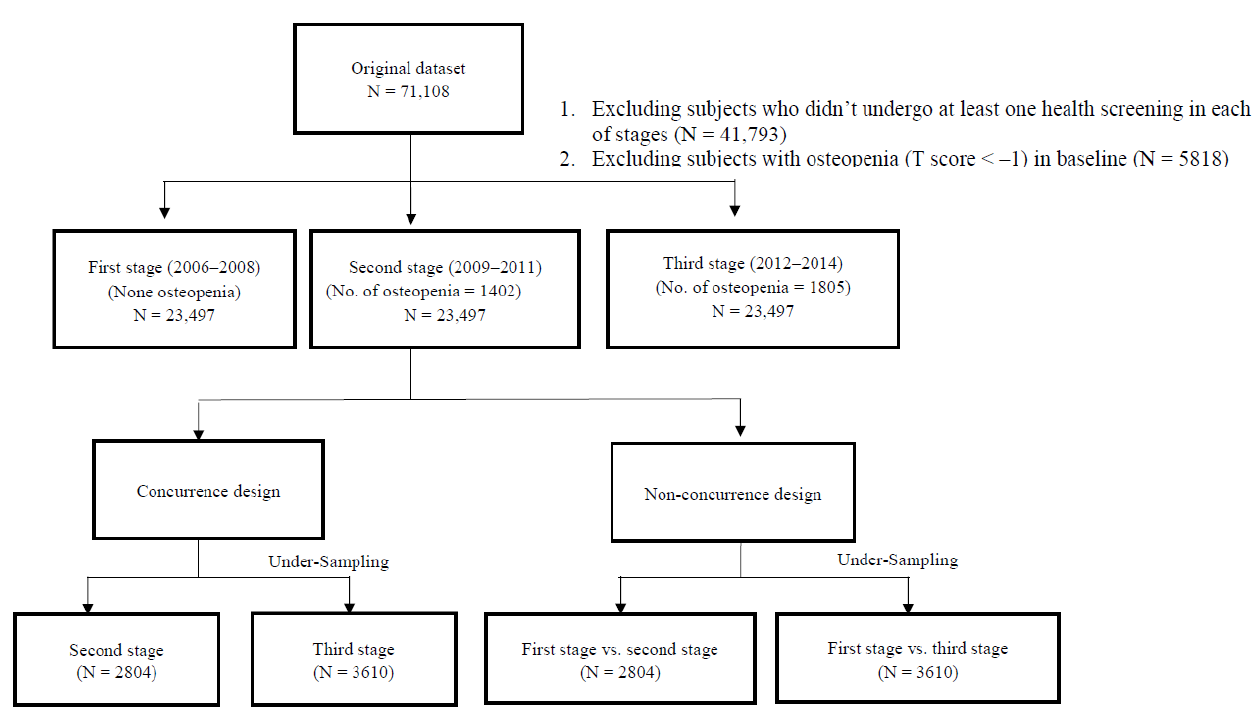
Figure 1. Flow chart of the data collection process used to identify study participants and define the analysis dataset.